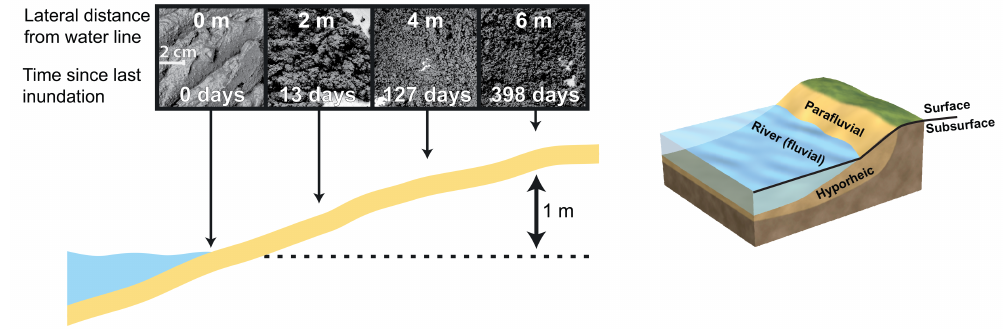
Figure 1. Diagram of parafluvial hyporheic zone and of sampling design with photographs of sieved sediment sampled. The four locations were spaced laterally at 2m intervals beginning at the water line and encompassed 1m of elevation change. Note changes in sediment moisture and texture with changes in inundation